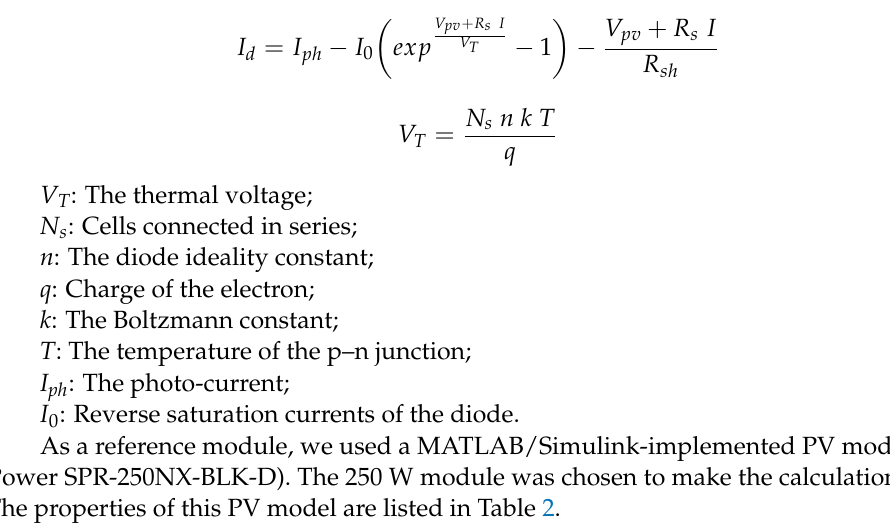
Figure 4. Equivalent electrical diagram of a photovoltaic cell.